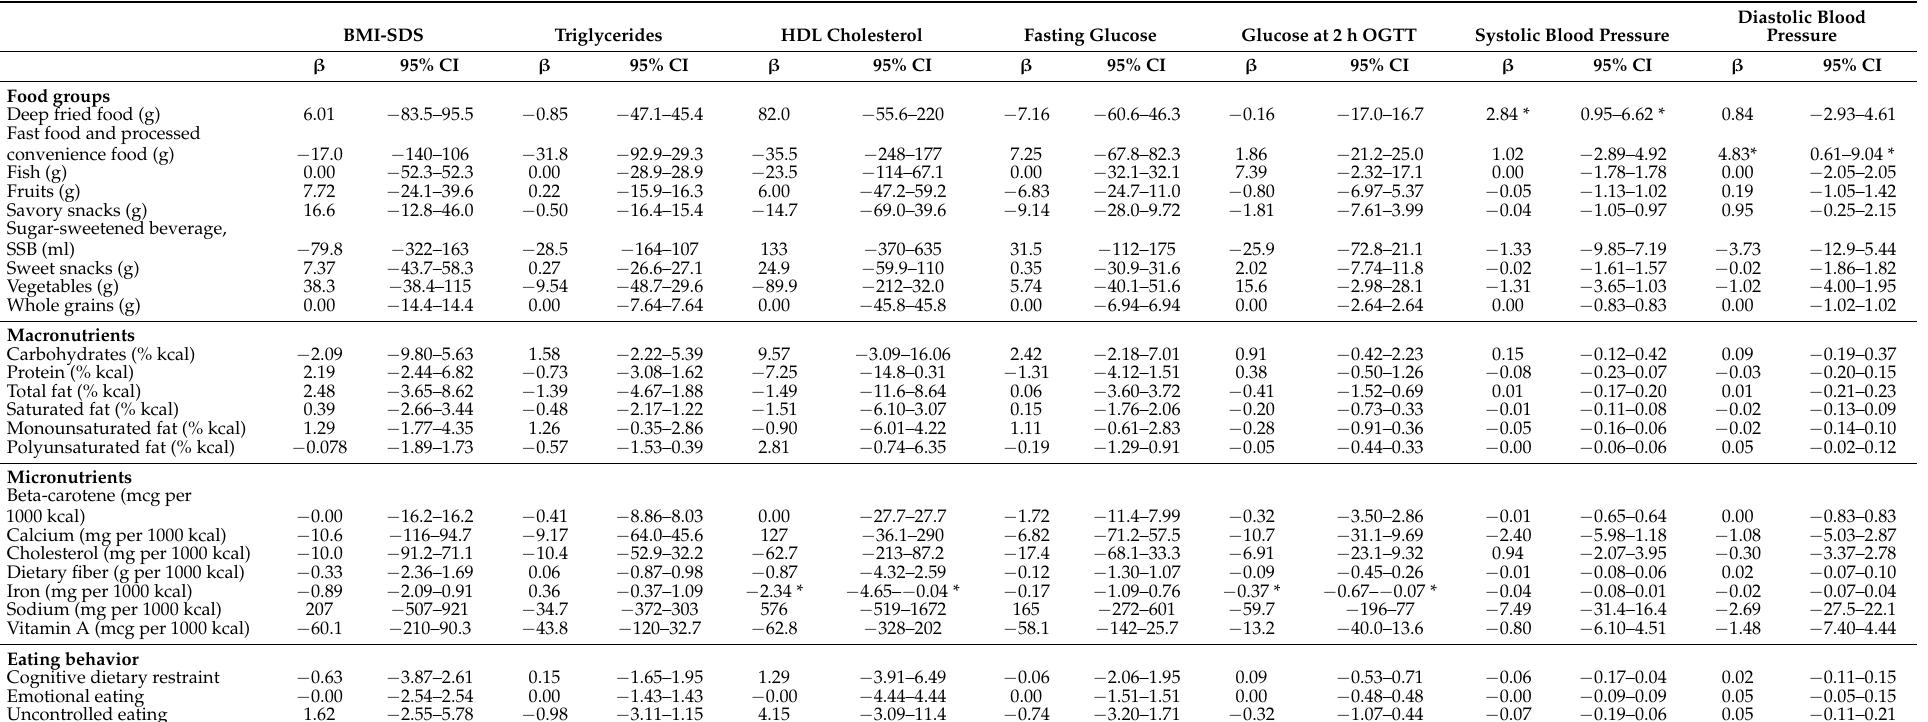
Table 5. Association between food groups/nutrients/eating behavior and continuous metabolic